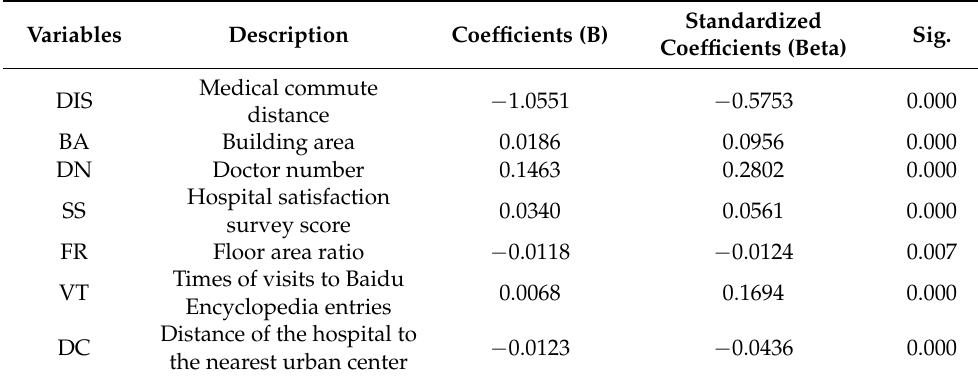
Table 3. The global regression results of the extended Huff model. Variables